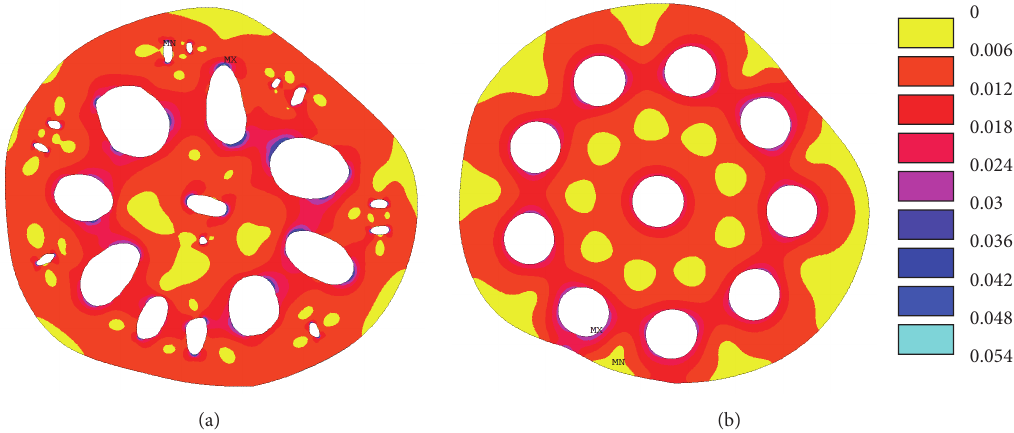
Figure 7: The von Mises stress (MPa) distribution: (a) the actual lotus root and (b) lotus root with circular holes.